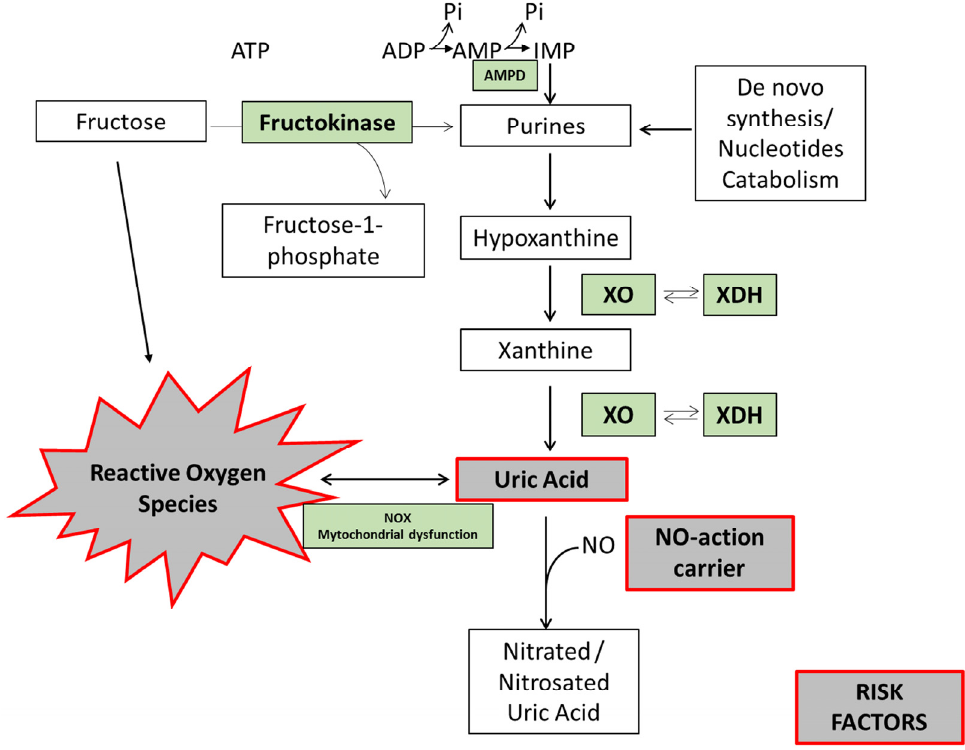
Figure 2. Fructose ‐ induced uric acid formation: risk factor biomarkers. In hepatocytes, fructokinase catalyzes the rapid phosphorylation of fructose to fructose-1-phosphate, using ATP as a phosphate donor. Intracellular phosphate (Pi) levels decrease, stimulating the activity of AMP deaminase (AMPD). AMPD converts AMP to inosine monophosphate (IMP). IMP is metabolized to inosine, which is further degraded to xanthine and hypoxanthine by xanthine oxidase (XO), ultimately generating uric acid